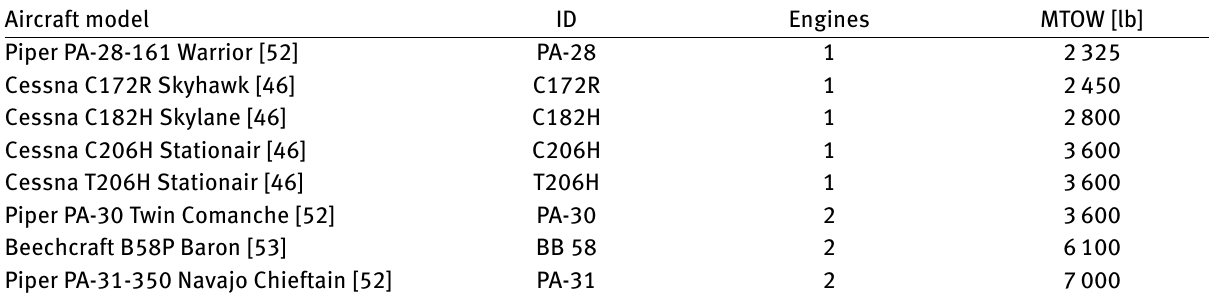
Table 2: Aircraft in the ANP database considered for the design of the blending coeflcients in the source-blending method. Aircraft